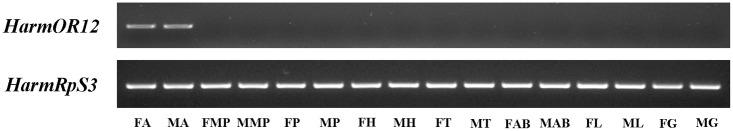
Tissue expression pattern of OR12 of H. armigera.FA: female antenna; MA: male antenna; Fmp: female maxillary palps; Mmp: male maxillary palps; FP: female proboscises; MP: male proboscises; FH: female heads; MH: male heads; FT: female thoraxes; MT: male thoraxes; Fab: female abdomens; Mab: male abdomens; FL: female legs; ML: male legs; FG: female genitalia; MG: male genitalia.